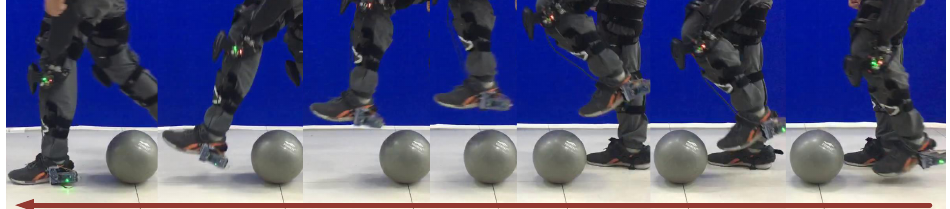
Figure 11. Stepping over an obstacle during walking. The arrow indicates the walking direction of the pilot.